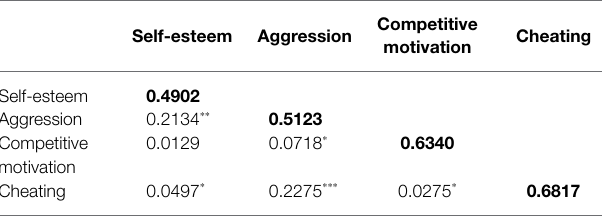
TABLE 2 | Correlations and discriminant validity